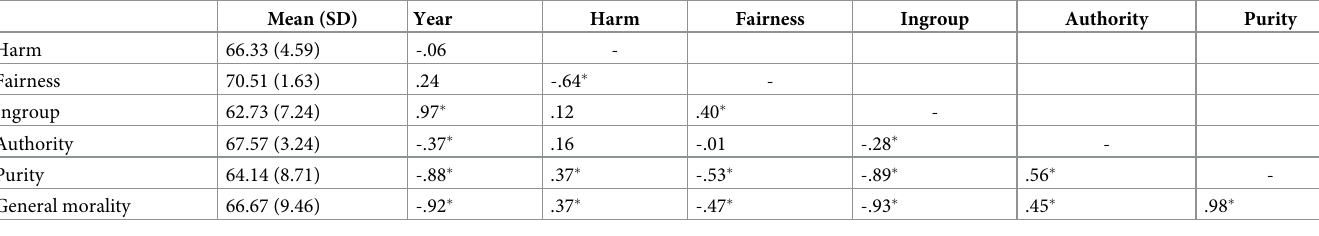
Table 1. Descriptive statistics and intercorrelations of the six moral dictionaries